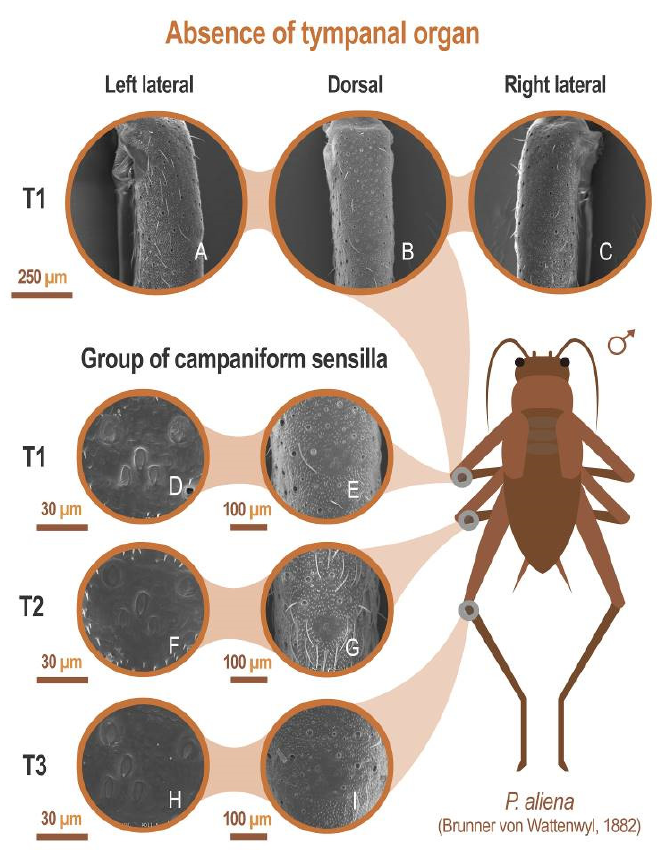
Figure 7. Absence of tympanic organ. SEM images showing the absence of tympani in the anterior tibia (T1) ( A – C ), and at different magnifications, the presence of clusters of flared sensilla in the proximal third of the tibiae anterior (T), middle (T2), and posterior (T3) tibiae ( D – I ). All SEM images have been performed on the left tibiae from the same specimen. Laterals ( B , C ) have been made with a 40° inclination. Specimen preserved in alcohol at 70% of the Orthoptera collection of the Entomology Laboratory of the Biology and Geology Department of the University of Almería. P. aliena Serrella (Sierra Serrella, Alicante, Spain), 10/2012. In all cases: P. Barranco col. and det. Table 3. Lifestyle and distribution. Summary of the lifestyle and distribution [3] of the species studied. The reference is indicated if the lifestyle is included in the publications and with (*) if the data are the authors’